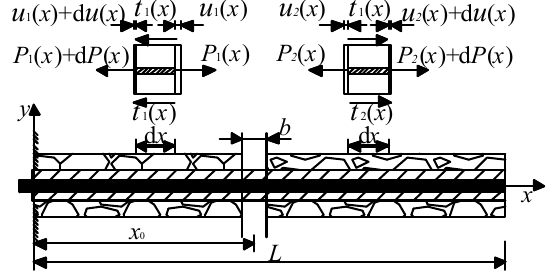
Figure 3. Static equilibrium of the anchorage micro-segment.